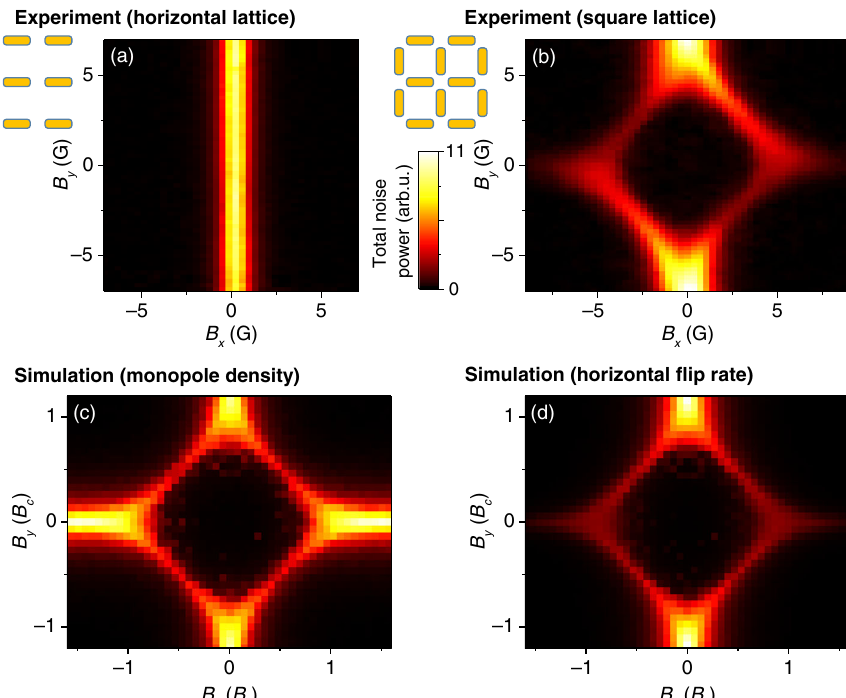
FIG. 3. Noise maps reveal the magnetic phase diagram of thermally active square ASI. (a) Map of the total magnetization noise power R P ð ω Þ d ω , integrated from 250 Hz to 250 kHz] from a control sample that contains only horizontal islands, versus applied in-plane [ magnetic fields B x and B y . Here, T ¼ − 10 . 0 °C. For B x ≈ 0 , the islands fluctuate spontaneously, but fluctuations are suppressed at larger (cid:1) B x where all the islands are polarized by the field. (b) Corresponding noise map from square ASI. The diamond-shaped boundary, where type-I and type-II vertices are degenerate in energy, is revealed by thermodynamic noise arising from the dynamics of type-III (monopole) vertices. The map lacks the fourfold symmetry of the square lattice because it measures only fluctuations along ˆ x but not ˆ y . The very slight skewing of the diamond is likely due to imperfections in the lithography. Supplemental Material Fig. S2 shows raw time- domain noise signals at various applied fields [26]. (c) Corresponding map of the calculated density of monopole vertices from Monte Carlo spin dynamics simulations. Along the diamond-shaped boundary where the density is large, the majority of the monopoles are freely diffusing (see Fig. 4). (d) Map of the calculated rate of horizontal magnetization flips, which is directly related to the measured total noise. Measured and simulated noise maps at T ¼ 6 °C and 23 °C, and measured noise maps for square ASI with a different lattice constant are shown in Supplemental Material Figs. S3 and S4